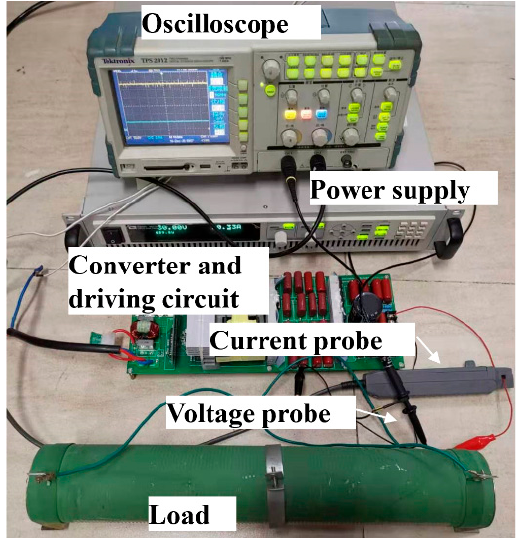
Figure 10. Experimental setup.